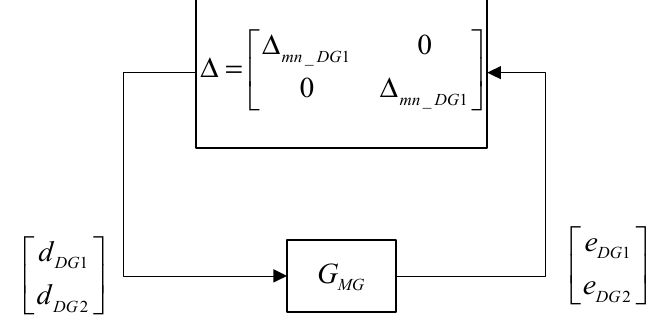
Figure 8. M − Δ configuration of a MG with uncertainty parameters.